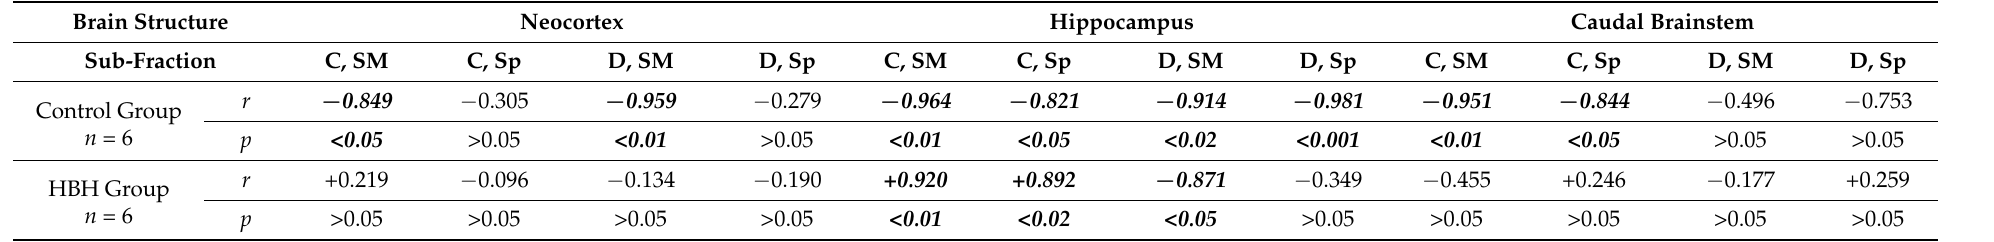
Table 2. Correlation between ChAT activity and PPI values in the total control and HBH groups of rats, Pearson’s r -criterion.